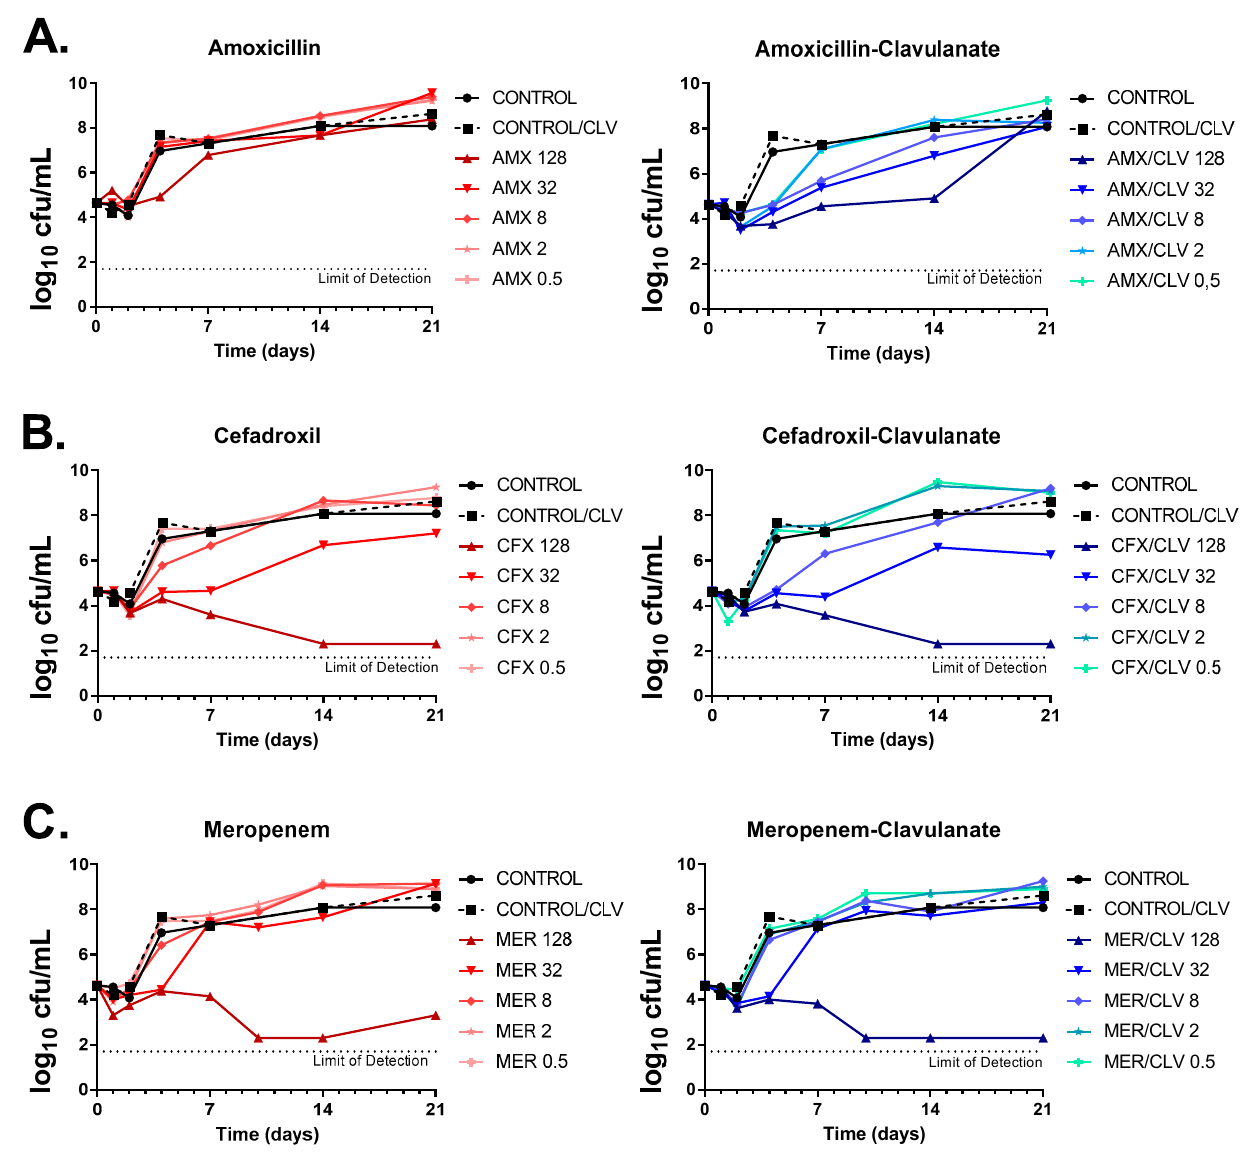
Figure 3. Dose-response time-kill assays of β -lactams against Mkn . ( A ) Amoxicillin, ( B ) cefadroxil and ( C ) meropenem were tested alone and in combination with clavulanate against the Mkn ATCC 12478 strain in Middlebrook 7H9 broth plus ADC. Two positive growth control cultures were included: one with no antibiotics (CONTROL) and one containing only clavulanate (CONTROL/CLV). Data represent one experiment of at least two independent experiments performed in duplicate. Clavulanate was added at a fixed dose of 4 mg/L. AMX: amoxicillin; CFX: cefadroxil; MER: meropenem; CLV: clavulanate.